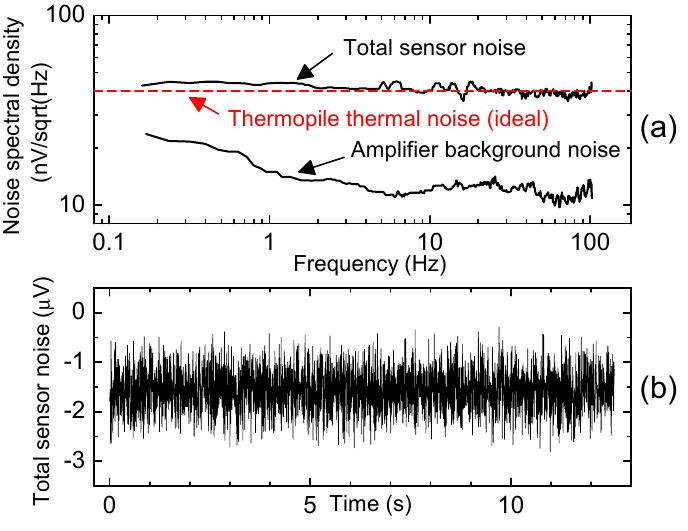
Figure 12. ( a ) Noise voltage spectral density (total sensor noise) referred to the amplifier input, measured on double heater samples with a total heater power (PH) of 2.5 mW, kept in still nitrogen. The heater power distribution on the two heaters was slightly